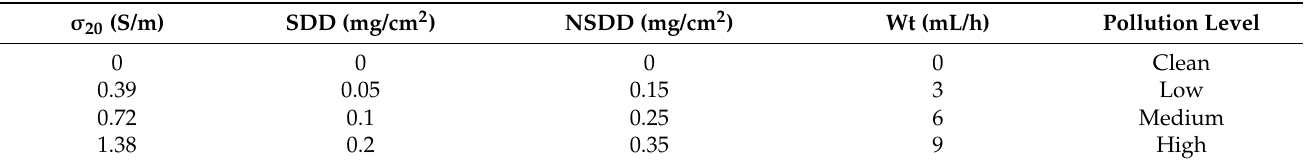
Table 2. Pollution layer